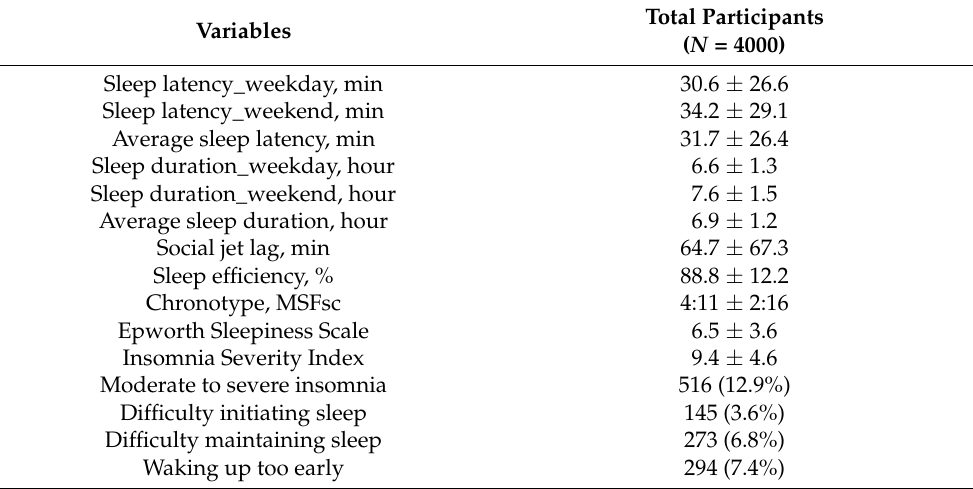
Table 2. Sleep patterns and circadian rhythms of the total